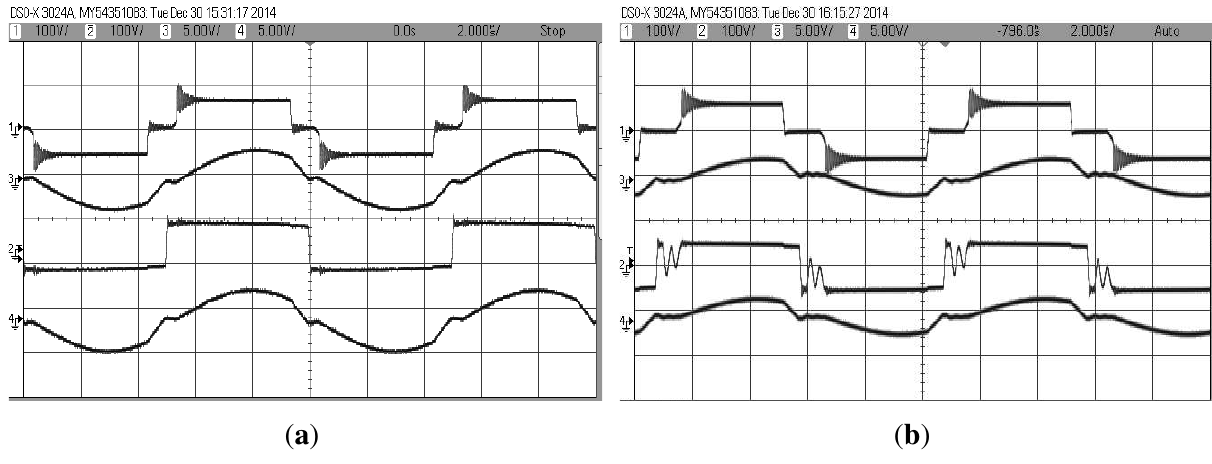
Figure 9. Experimental plots of: ( a ) output power, 100 W; ( b ) output power, 50 W. Waveforms from top to bottom in each case: v secondary side). Voltage scale: 100 V/div; current scale: 5